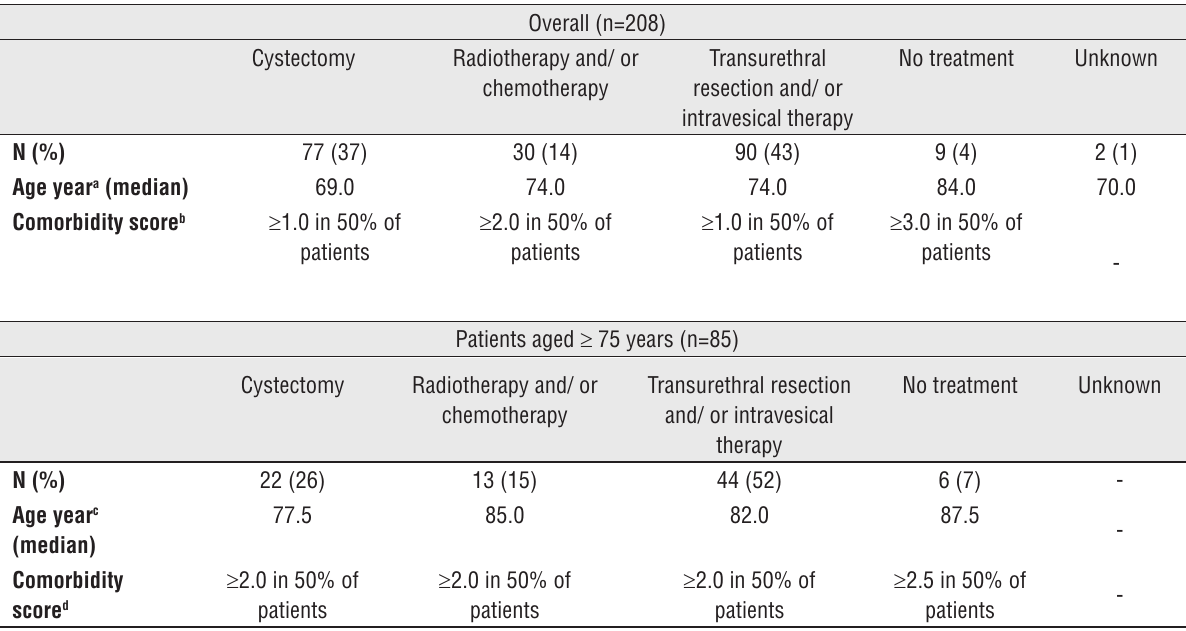
a Independent sample T-test for age at cystectomy vs. radiotherapy and/ or chemotherapy p=0.016; b Independent sample T-test for comorbidity at cystectomy vs. radiotherapy and/ or chemotherapy p=0.008; c Mann-Whitney U test for age at cystectomy vs. radiotherapy and/ or chemotherapy p<0.001; d Mann-Whitney U test for comorbidity at cystectomy vs. radiotherapy and/ or chemotherapy p=0.334 note: Comorbidity was scored for: cardiovascular disease, hypertension, pulmonary disease, diabetes and previous malignancy. If present, 1 point per category was scored. Please note, this is not the Charlson Comorbidity Index